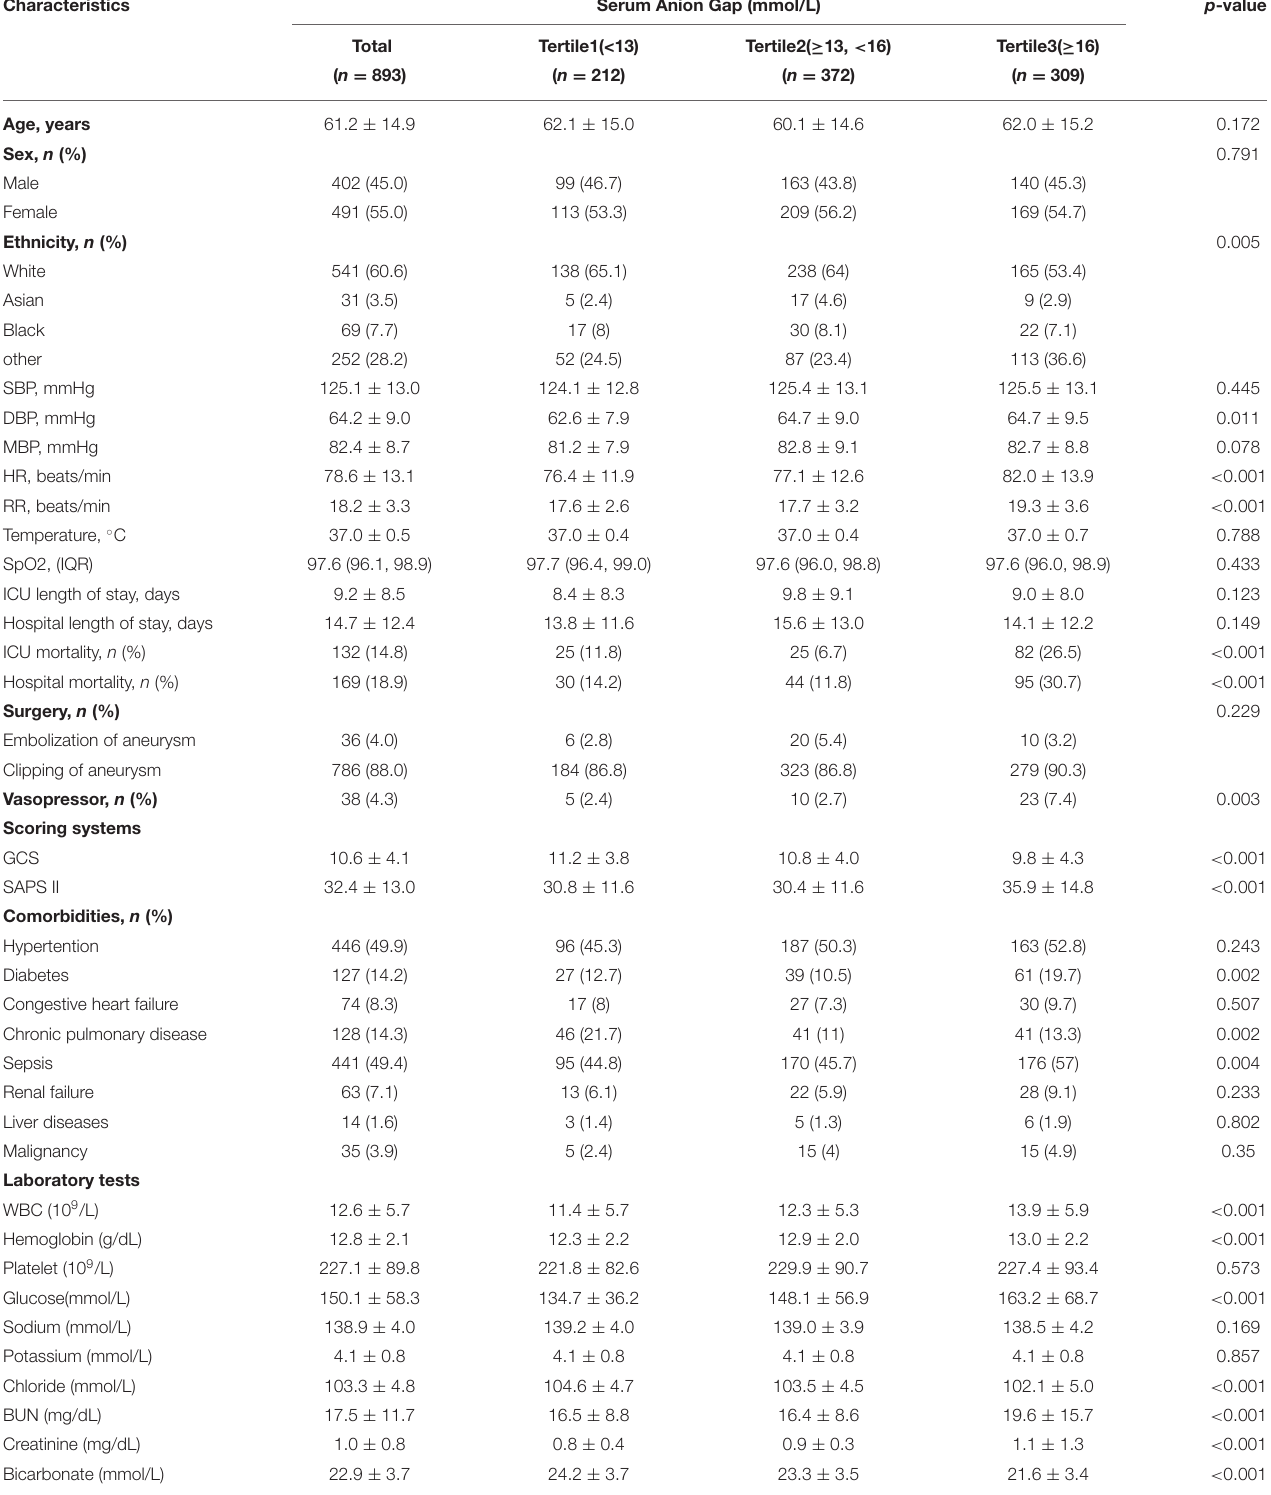
TABLE 2 | The clinical characteristics of critically ill patients with non-traumatic SAH.